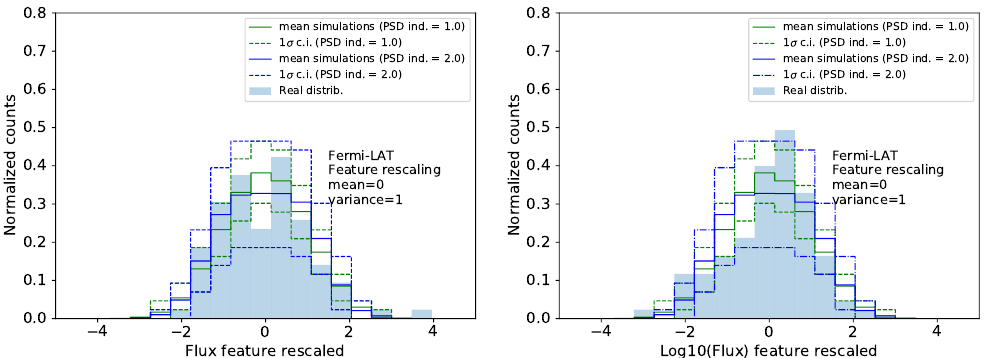
Figure 2. The rescaled flux distribution of the long-term GeV Fermi -LAT light curves is shown here (for E > 1 GeV) for the flux ( right panel ) and the log of the flux ( left panel ). The blue histogram is 10 obtained from the real Fermi -LAT monthly light curve. The solid lines are the mean obtained from the light curve simulations with PSD index = 1 (green line) and PSD index = 2 (blue line). The dashed and dot-dashed lines represent instead the 1 sigma confidence intervals obtained by taking the 16th and 84th percentile of the distribution of the entries in the bins for the 5000 simulations adopted. These results are robust to variations in binning and show no significant deviation between the Fermi -LAT data and a simulated normal distribution of the